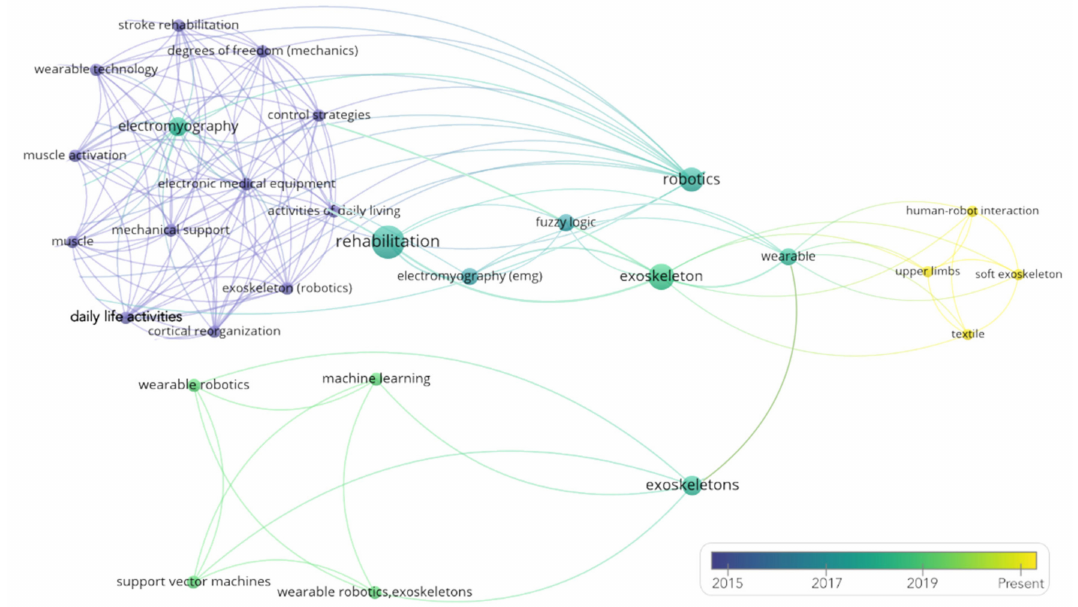
Figure 4. Time evolution and interconnections of the reviewed topics. Map generated with VOSViewer